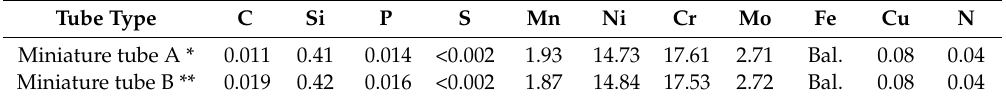
Table 3. Chemical composition AISI 316L for two kinds of miniature tube with 1.8 mm in diameter